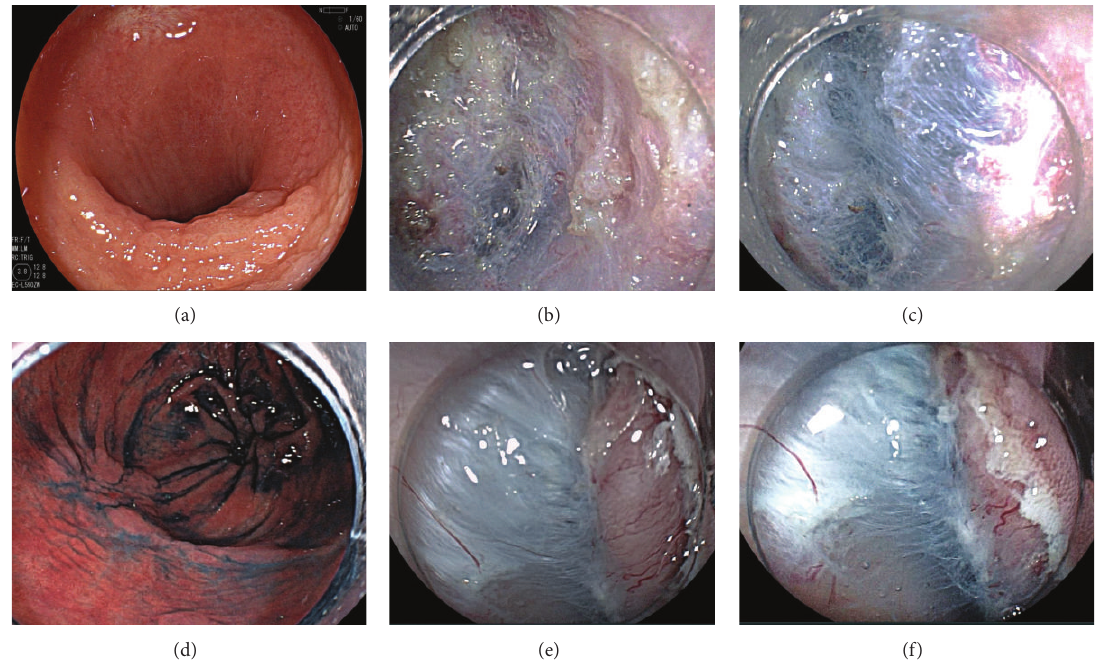
Figure 4: (a) Superficial tumor 60 mm in diameter with ulcerative colitis. (b) Severe fibrosis was detected in the submucosal layer. (c) Blue layer was seen in severe fibrosis after injection. (d) Recurrent lesion 30mm in diameter after endoscopic mucosal resection. (e) Severe fibrosis was detected in the submucosal layer. (f) Blue layer was seen in sever fibrosis after injection.